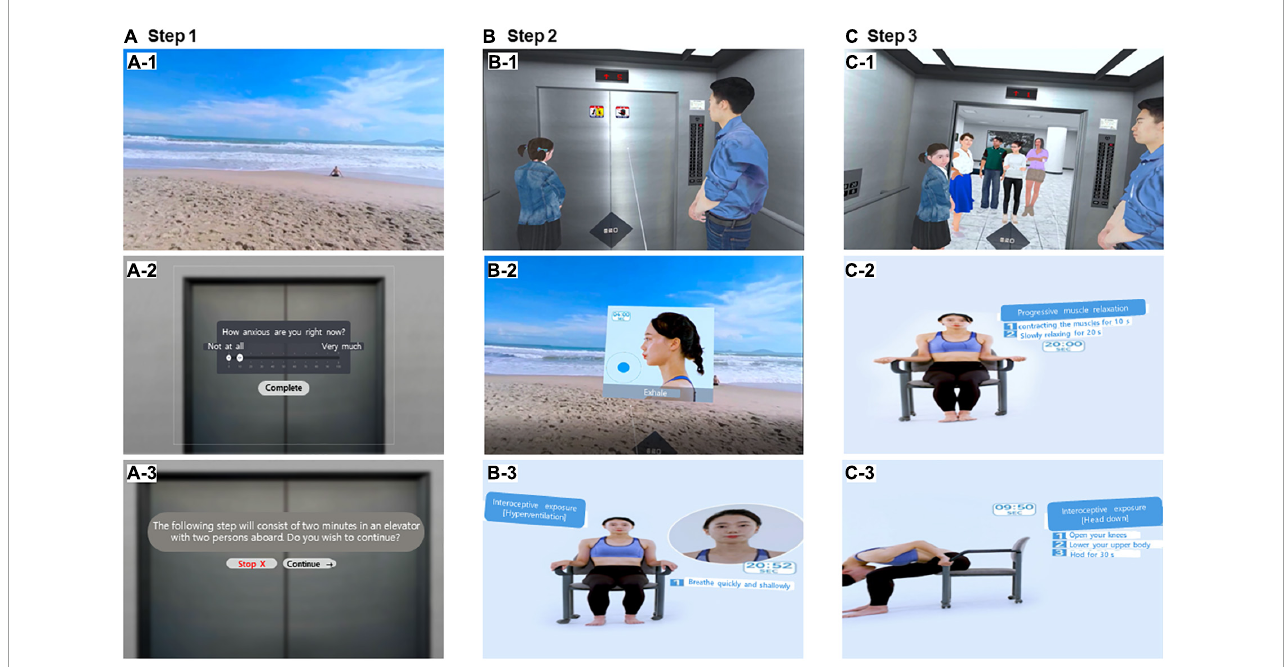
FIGURE2 Screenshots of the virtual reality-based assessment in panic disorder (VRA-PD). In the program, Modules 1, 2, and 3 consisted of three steps (pre-evaluation, step 1, and step 2). Module 0 (baseline evaluation module) with a comfortable virtual environment composed of beach scenes (A-1) . A comfortable virtual environment (A-1) was employed in step 1 of Module 1. In addition, it was also used in Module 3 at 1 min and 30 s in the second half of the interoceptive exposure of Step 2 and Step 3. Users rate their self-rating anxiety scores on the visual analog scale constructed in the virtual environment (A-2) . Users selected whether to proceed at each step and each module (A-3) . In Module 1, Steps 2 (B-1) and 3 (C-1) each consist of 2 min process in an elevator with two and six passengers, respectively. Users performed diaphragmatic respiratory relaxation (DRR) in step 2 (B-2) of Module 2 and progressive muscle relaxation (PMR) in step 3 (C-2) for 2 min each according to human motion, guidance, and time displayed in the virtual environment. Panel (B-3) shows the hyperventilation virtual environment of module 3, and panel (C-3) shows the head down virtual environment. In Module 3, the guidance in the virtual environment was used in the same manner as in Module 2 for 30 s to provide stimulation. Panel (A-1) shows the comfortable scene for the remaining 1 min and 30 s. The program was conducted in Korean; however, the examples of the help balloon in this figure are presented in English to aid the understanding of